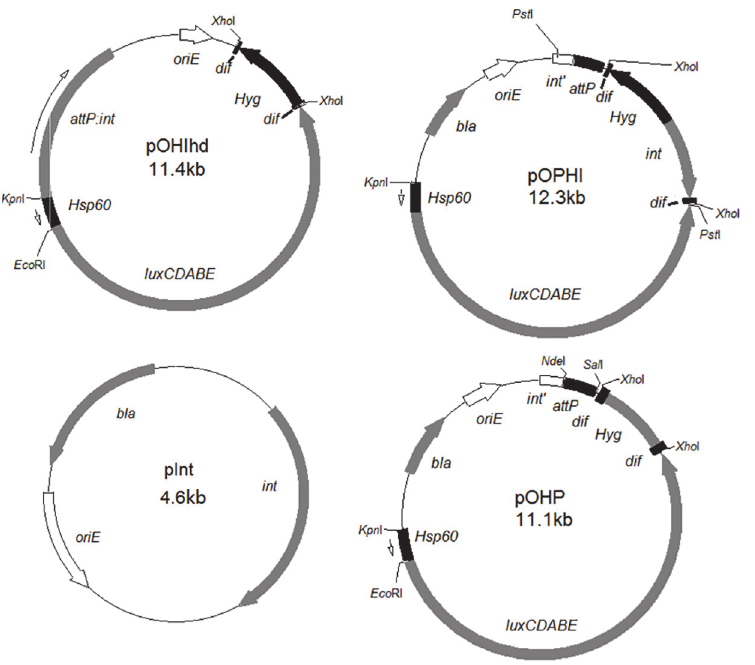
Fig 1. The plasmids constructed in this study for transforming into mycobacteria to create unmarked autoluminescent mycobacteria. oriE , origin region of E . coli ; Hsp60 , the strong mycobacterial promoter; luxCDABE , the operon for producing autoluminescence; bla , ampicillin resistance gene; Kan , KAN resistance gene; res , the transposon γδ resolvase action site; attP , mycobacteriophage L5 attachment site; int , integrase gene; int ’ , the remaining part of integrase gene; attB , attachment site from the mycobacterial genome corresponding to attP ; oriM , origin region of mycobacteria; Hyg , HYG resistance gene; dif , the recombinases XerCD action